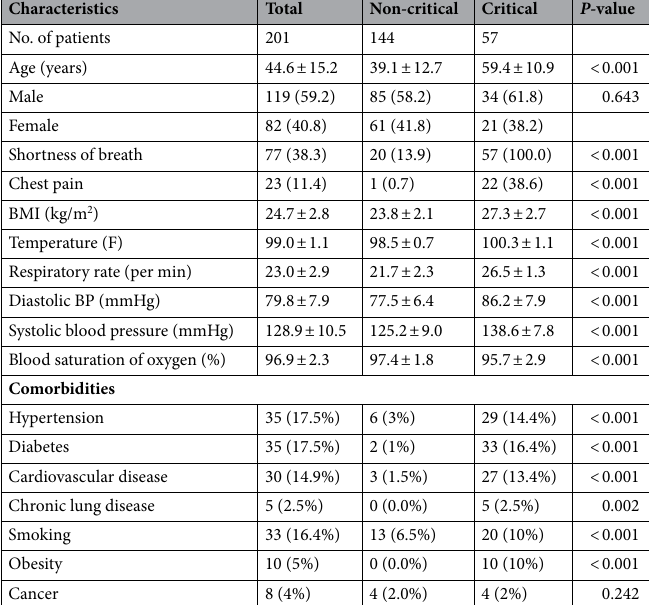
Table 1. Demographics and clinical characteristics of Covid-19